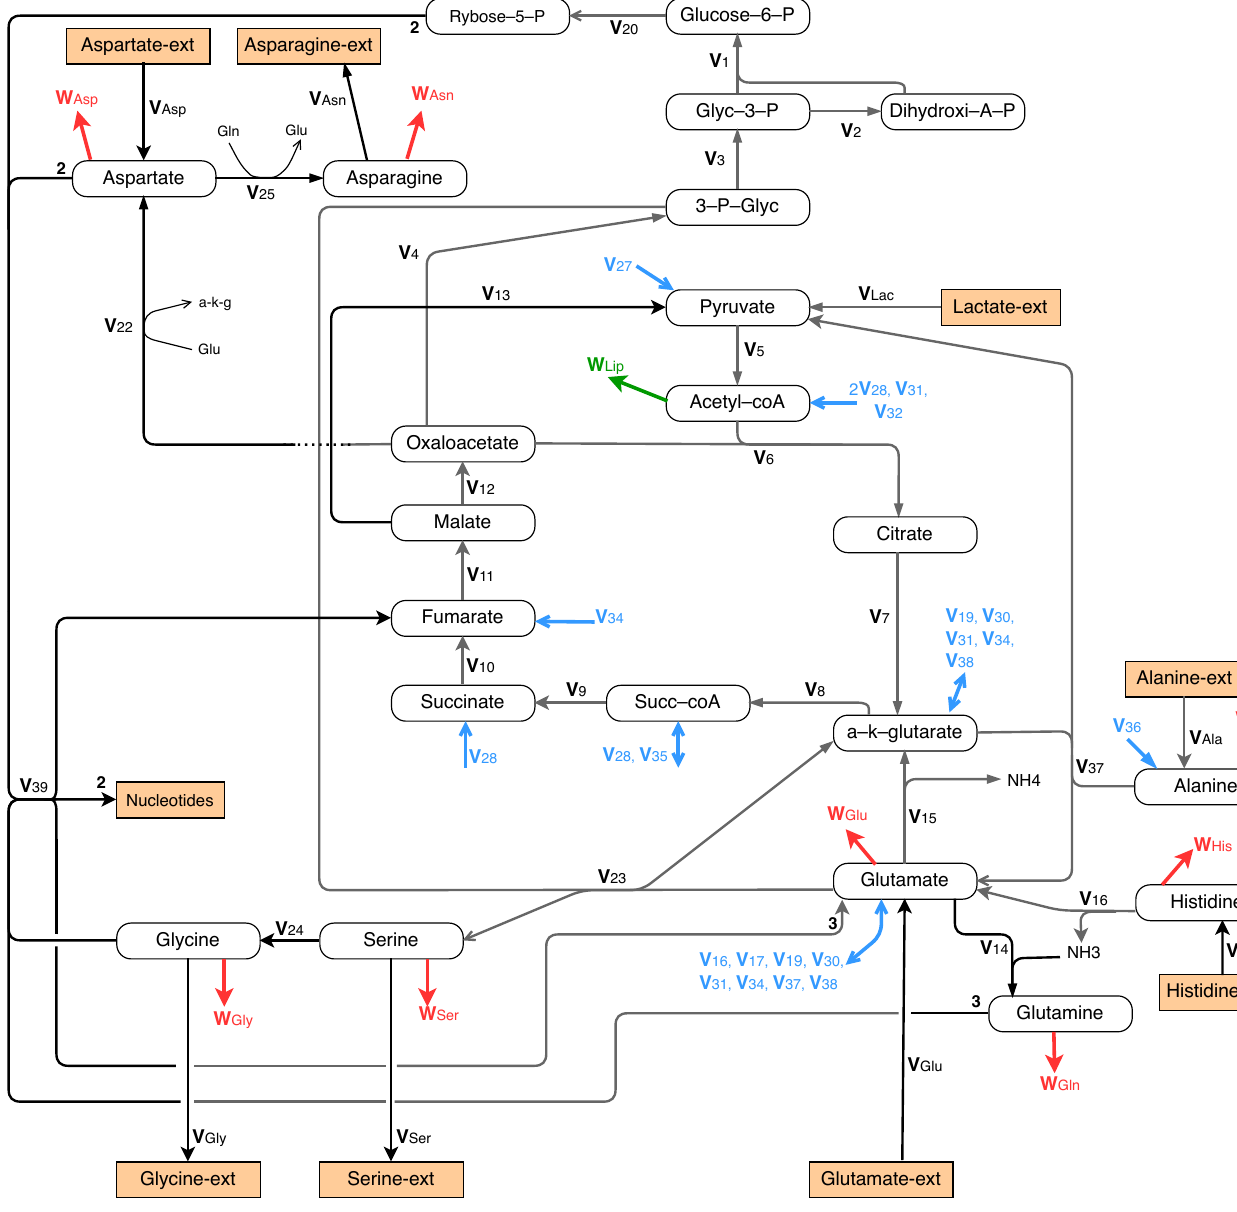
Figure 9. Growth without glucose and glutamine: central metabolism involving glyconeogenesis, TCA, and glutamine synthesis, nucleotide synthesis and metabolism of alanine, asparagine, aspartate, histidine, glycine, and